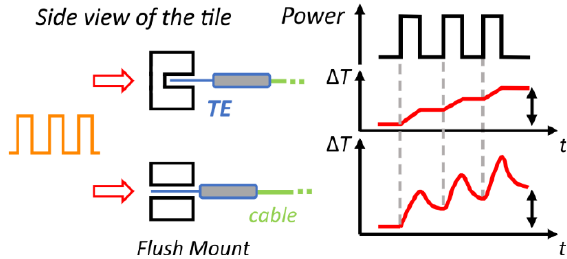
Fig. 5. Schematic comparison of thermocouple (TE) mount options and signal response on an incoming pulse train of mm- wave power. Top: Mounted from the rear inside the bulk material. Bottom: Flush mount, the borehole goes through the surface and the TE is partly exposed to the mm-wave. The On/Off time of the power is of the same order as the relaxation time of the thermocouple. If the total heat capacity of the absorbing material is comparable, then the total temperature rise after the last pulse plus relaxation time is also comparable (double sided arrows on the right).